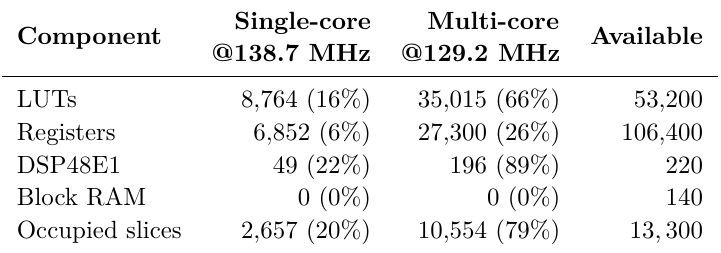
Table 6: Device utilization and maximum clock frequency on Xilinx Zynq-7020